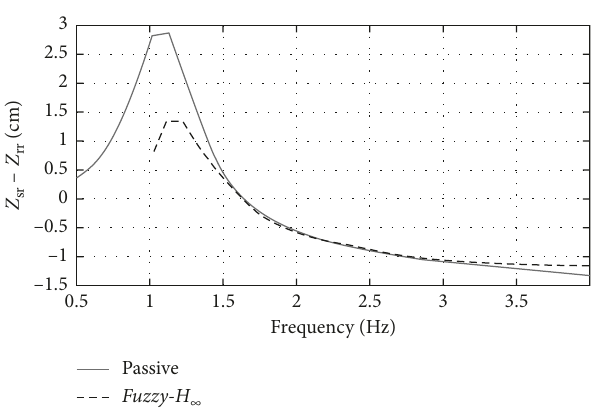
Figure 19: Rear suspension deflection